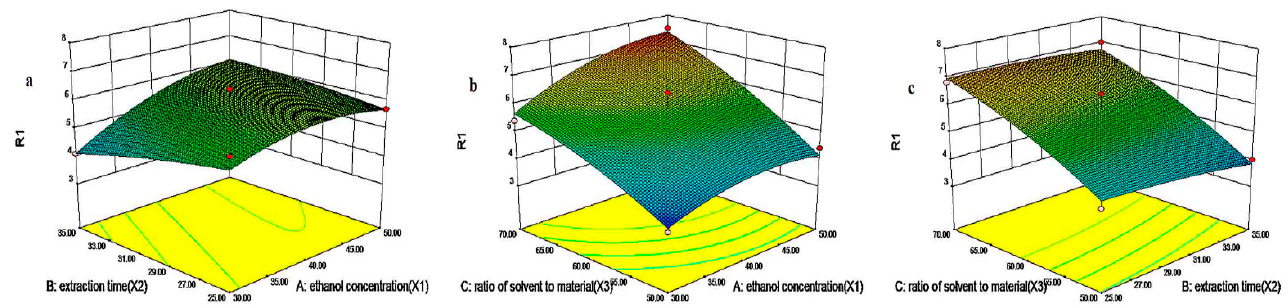
Figure 2. ( a – c ) Response surface plots of ethanol concentration (X1, %), extraction time (X2, min), and ratio of solvent to material (X3, mL/g) on the extraction yield of TFW. BBD can be used to optimize the extraction of flavonoids by considering the